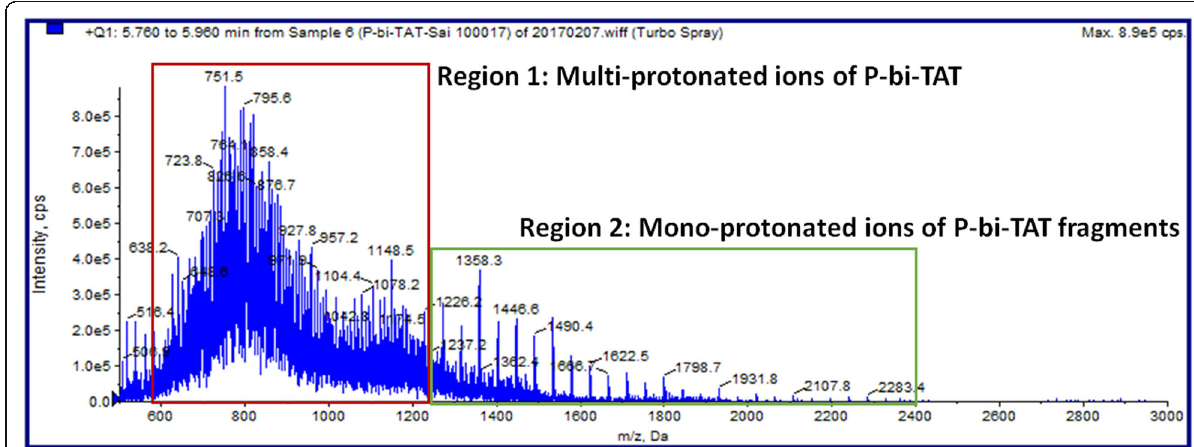
Fig. 3 Mass spectrum of P-bi-TAT in positive ESI scan